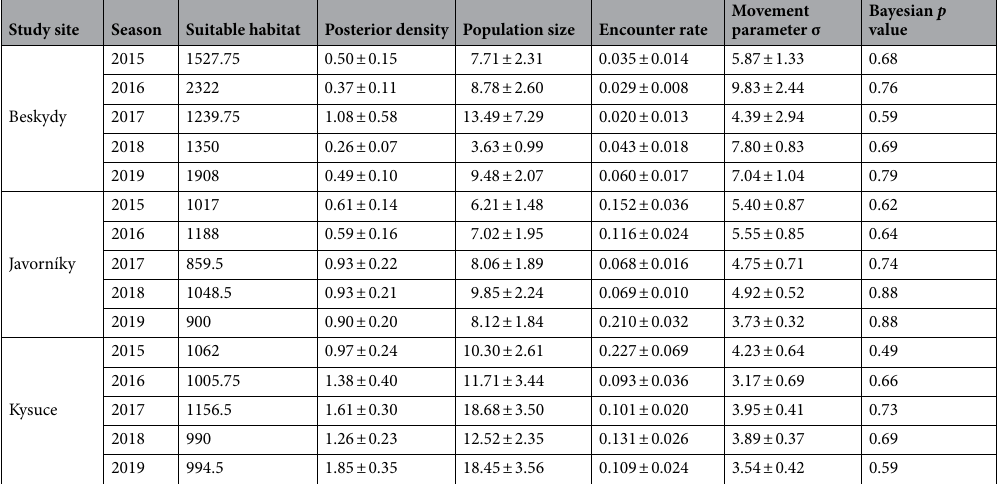
Table 2. Population size and density estimates of Eurasian lynx during five seasons of systematic camera- trapping in three study sites in the Western